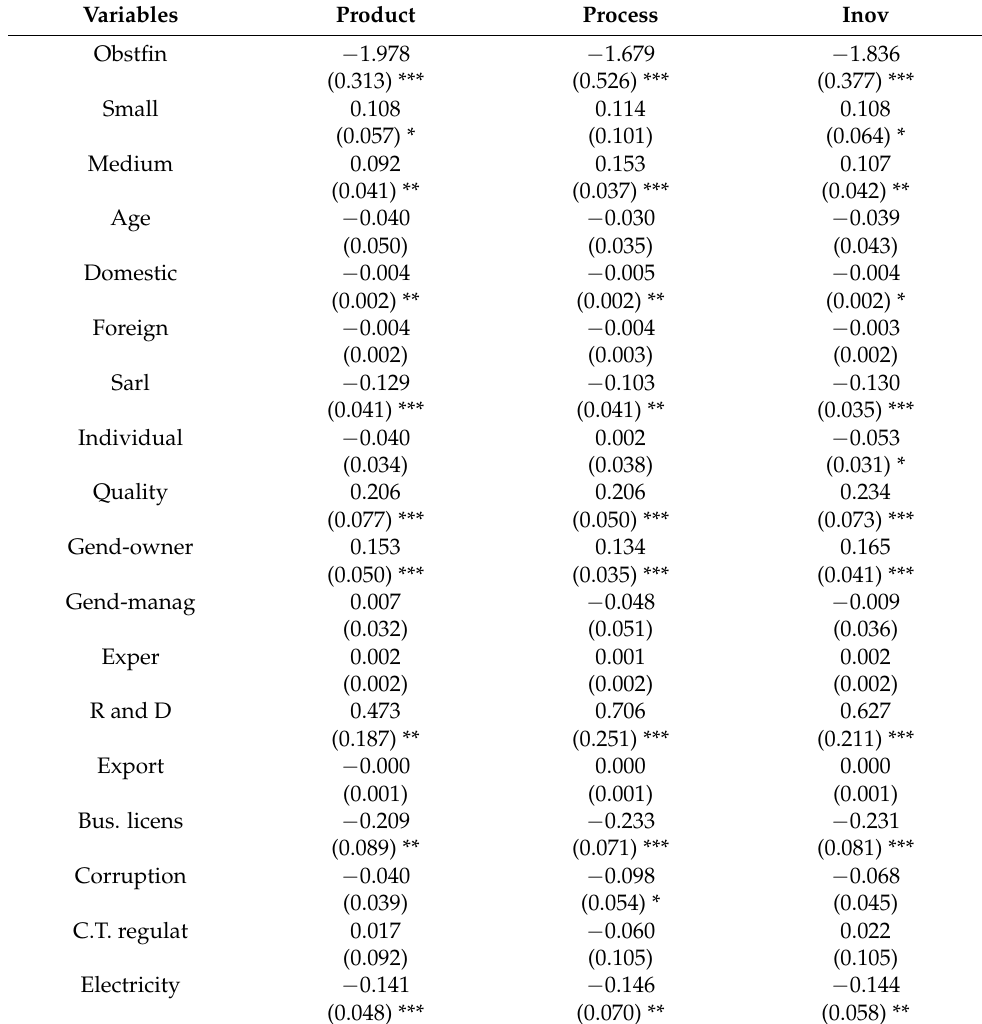
Table 6. IV-probit regression of non-financial barriers to